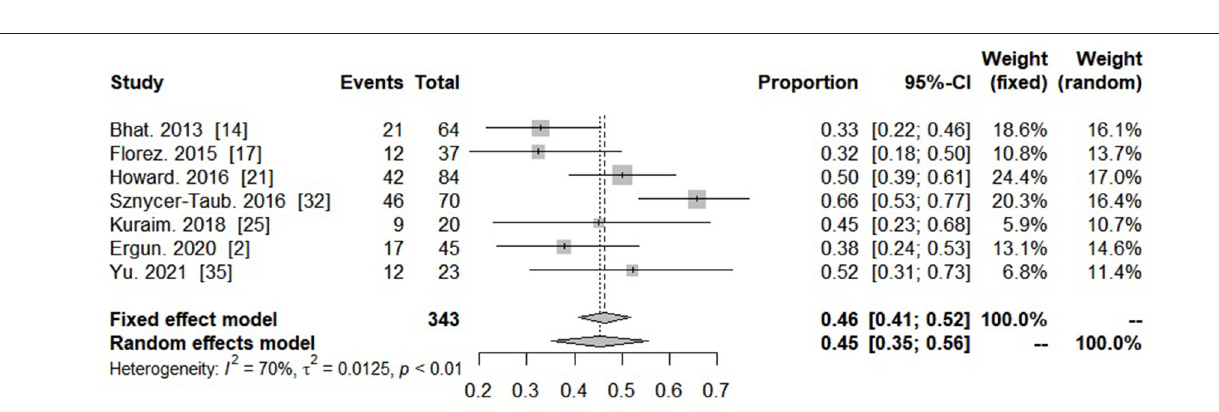
and reduces the risk of cardiovascular collapse (3). While there is no consensus on the timing for ECMO initiation in the perioperative period, our meta-analyses showed that neonates and pediatric patients with LCOS supported with ECMO had lower mortality than patients with ECMO after cardiac arrest